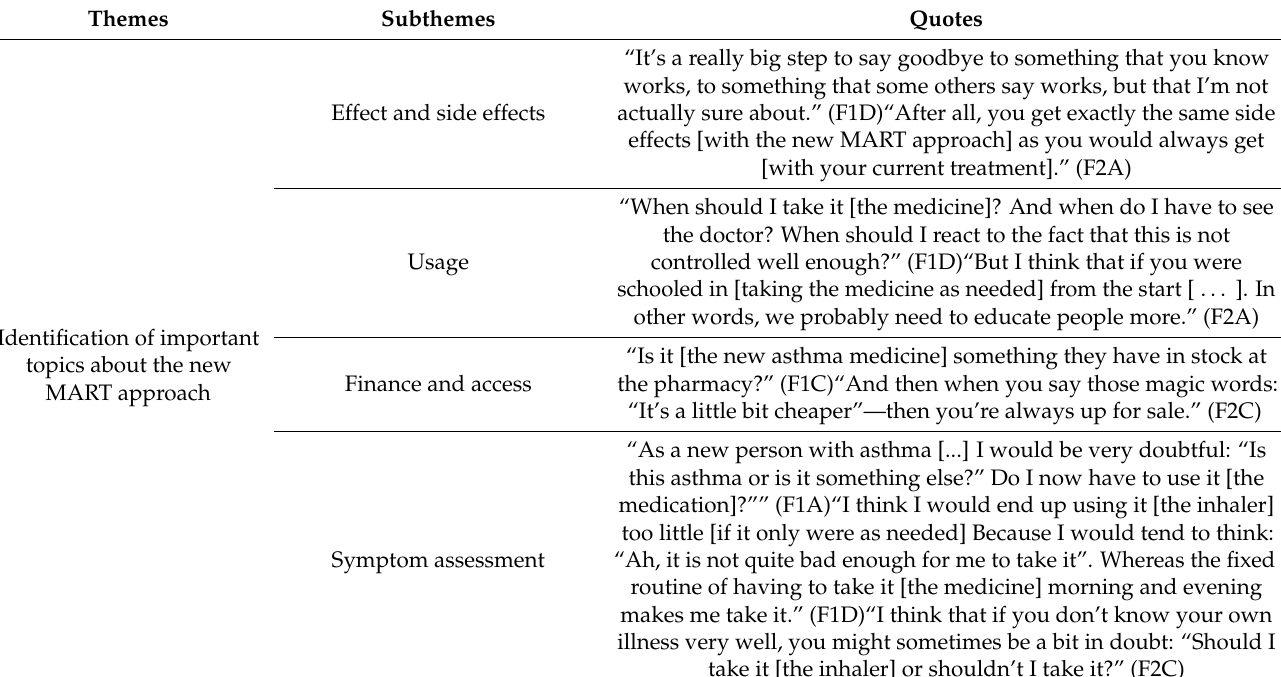
Table 3. Themes, subthemes, and examples of quotes from both first and second focus group